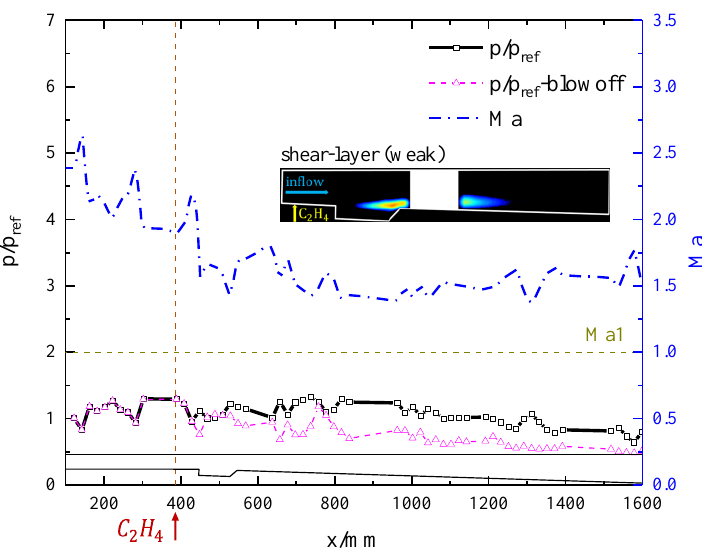
Figure 5. Dimensionless pressure/Mach number along x axis and mean pseudo-color image of CH* chemiluminescence at Case 9 (1.7D 0 I0.099).